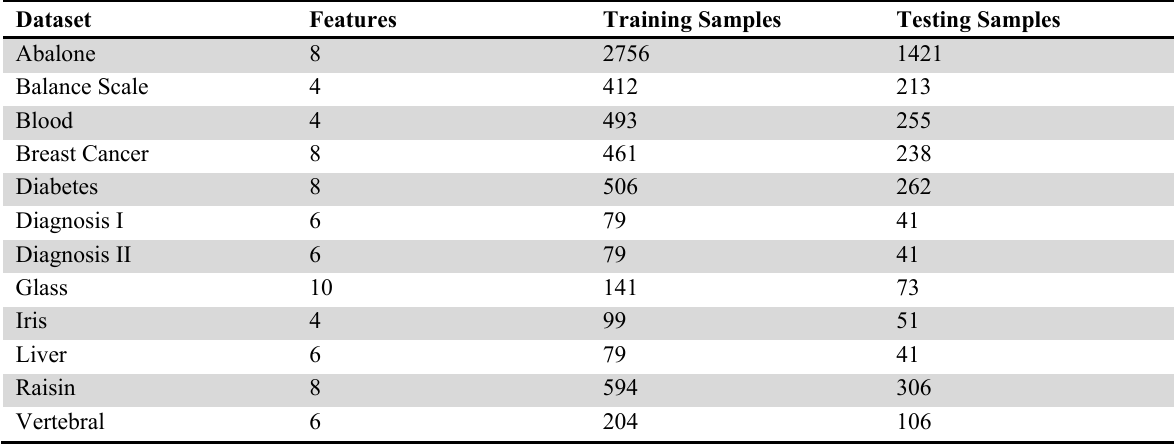
Classification datasets Dataset